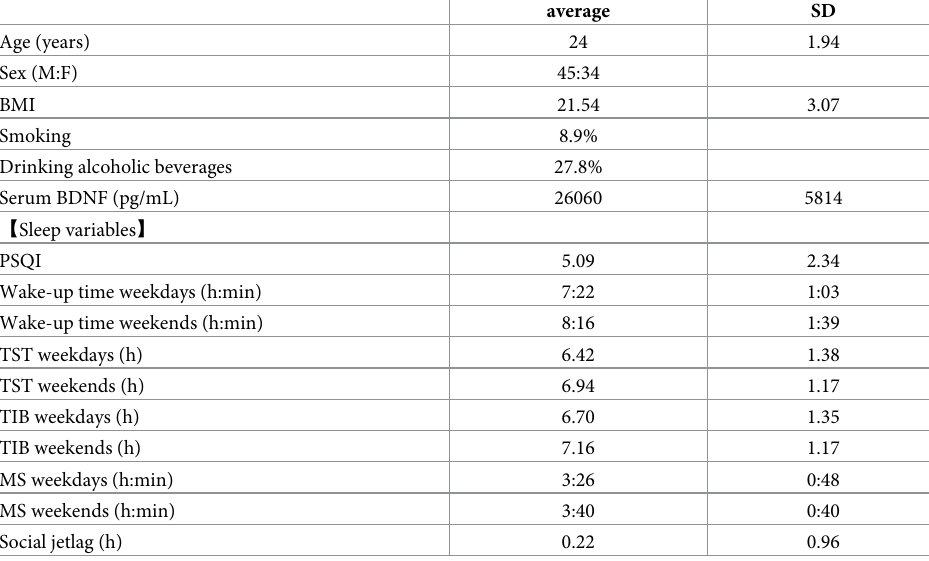
Table 1. Characteristics of study